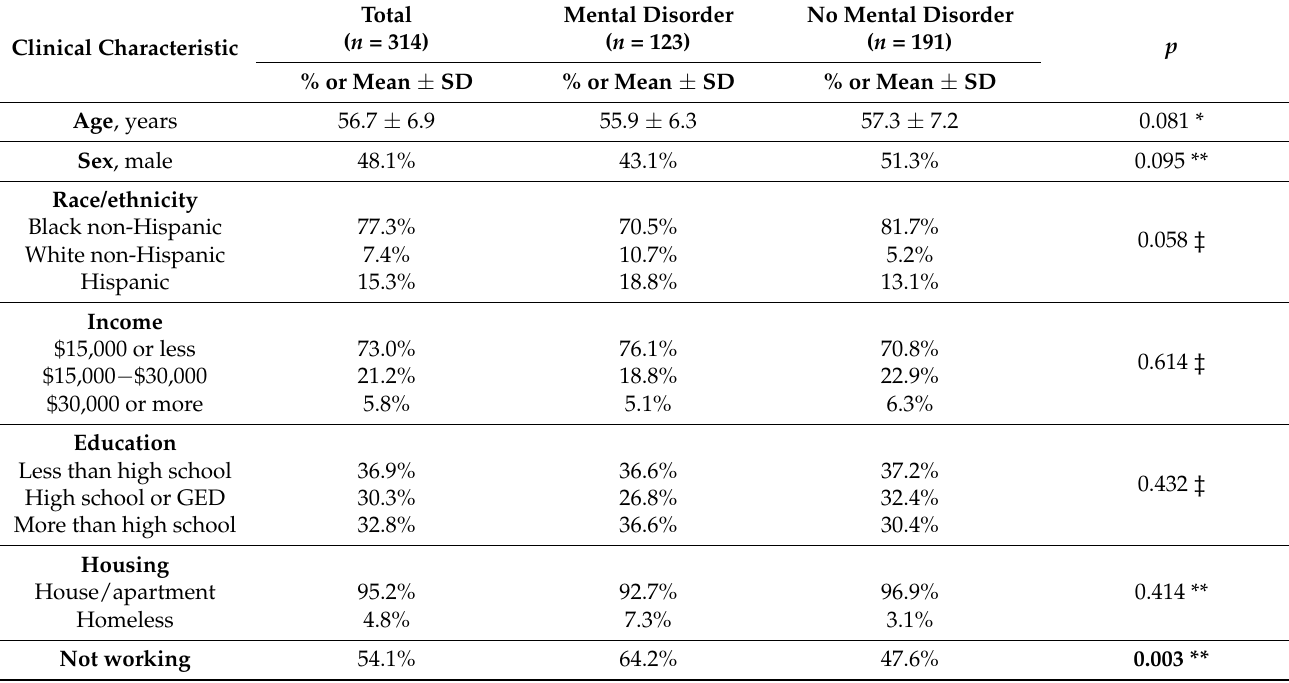
Table 1. Socioeconomic and clinical baseline characteristics of participants with and without pre- existing mental